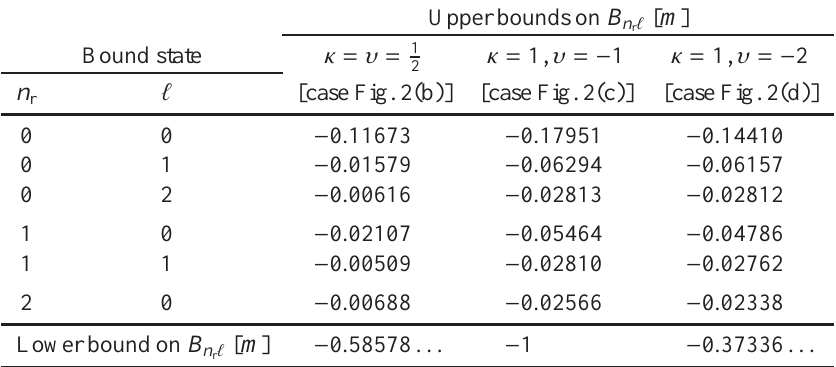
Table 2. Bounds on binding energies, for states of radial excitation n r and orbital angular momentum ℓ , for exemplary spinless relativistic generalized-Hellmann problems [21, 22] ( b = µ = m , β = 1, d '